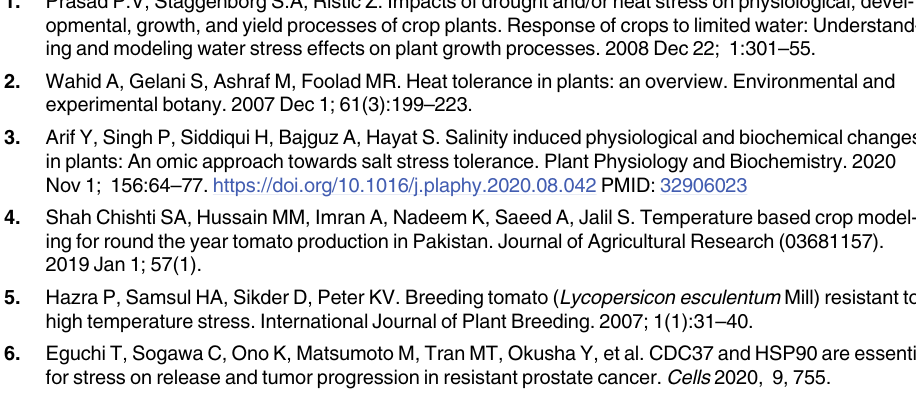
S2 Table. Performance of selected 10 genotypes for cell viability and cell membrane stabil- ity %. S3 Table. Schematic presentation of conserved motifs in SlHsp100 proteins. S4 Table. Analysis of conserved motifs of SlHsp100 proteins in tomato. S5 Table. Functional divergence analysis from pairwise comparison of the SlHsp100 pro- tein family